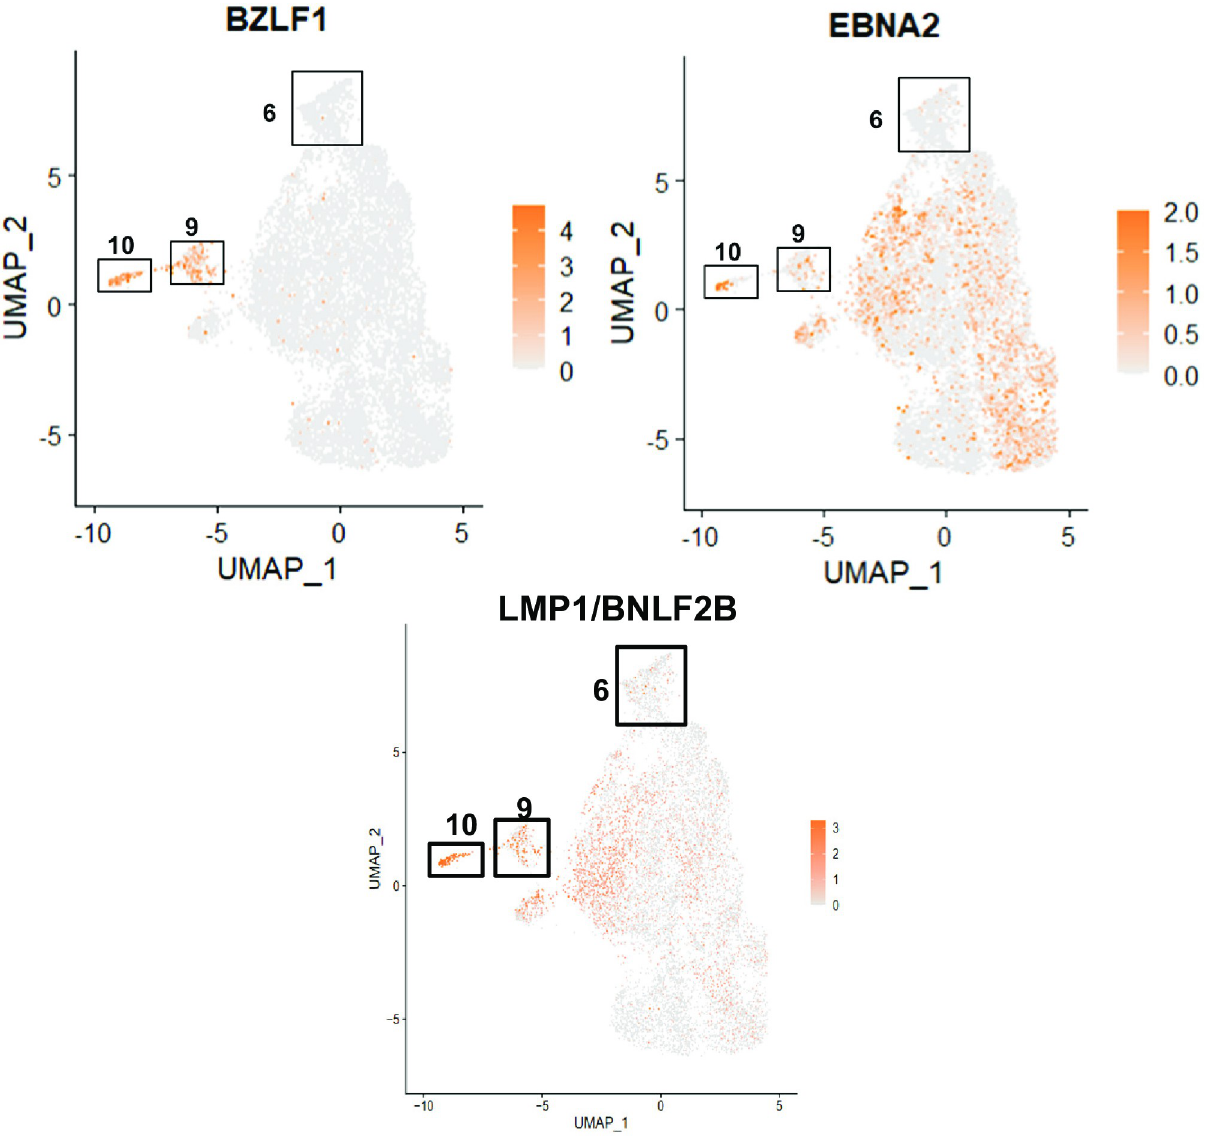
Fig 13. BZLF1 (lytic gene expression) is limited to clusters 9 and 10, whereas latent proteins EBNA2 and LMP1 are expressed more broadly. Expression values are based on log normalized counts. LMP1/BNFL2B expression (overlapping transcripts) was log transformed and averaged to show grouped expression and overcome 3’ prime bias with